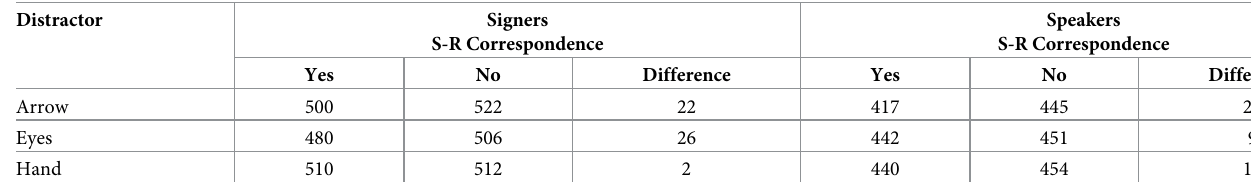
Distractor Signers